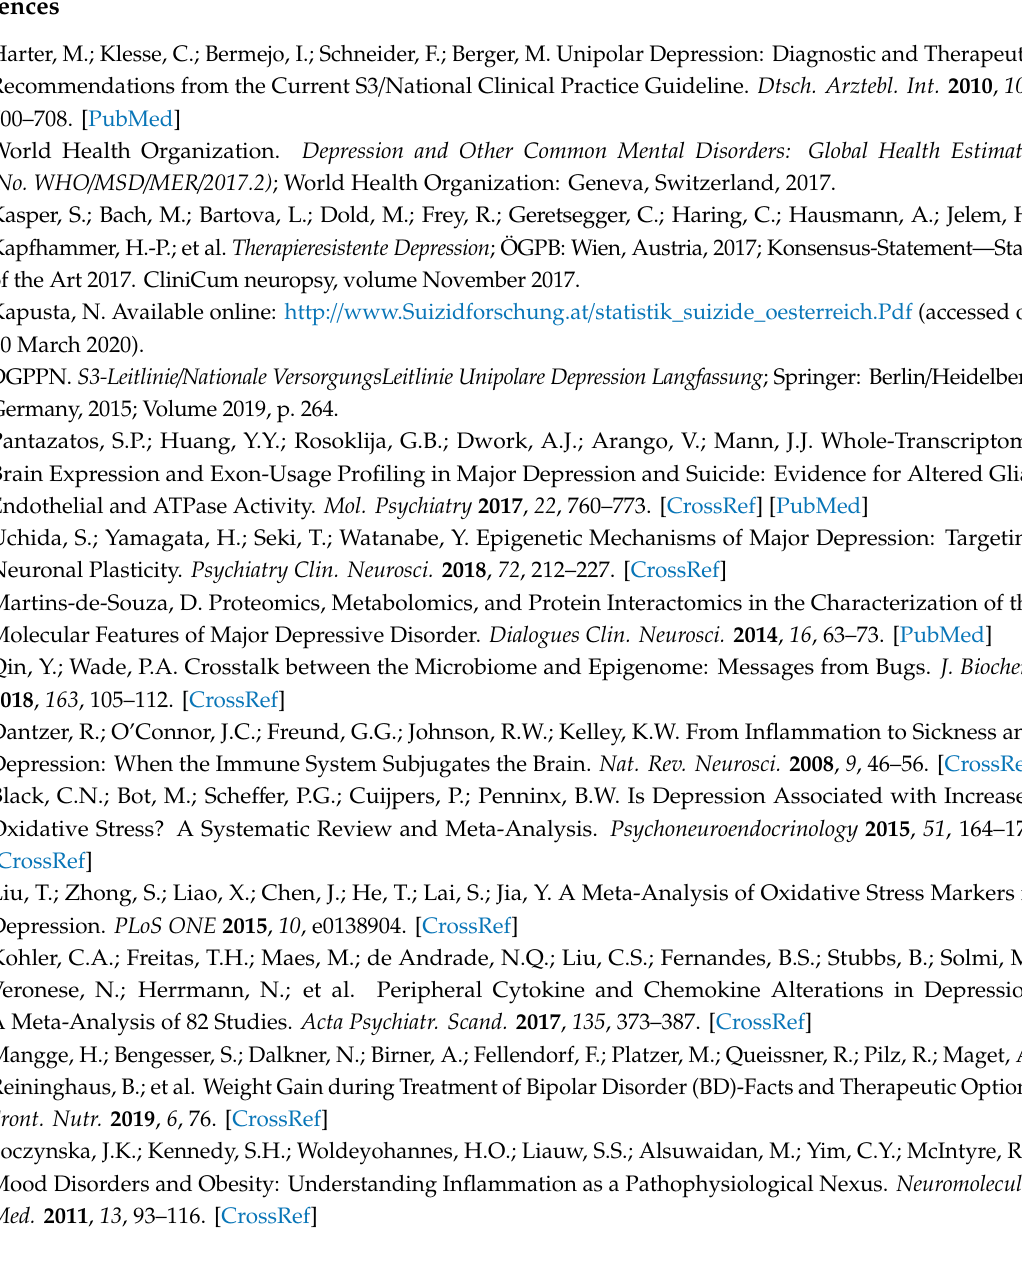
Figure S1: Enrichment Map of Biological Processes for the Interactome of IL6, TNF,